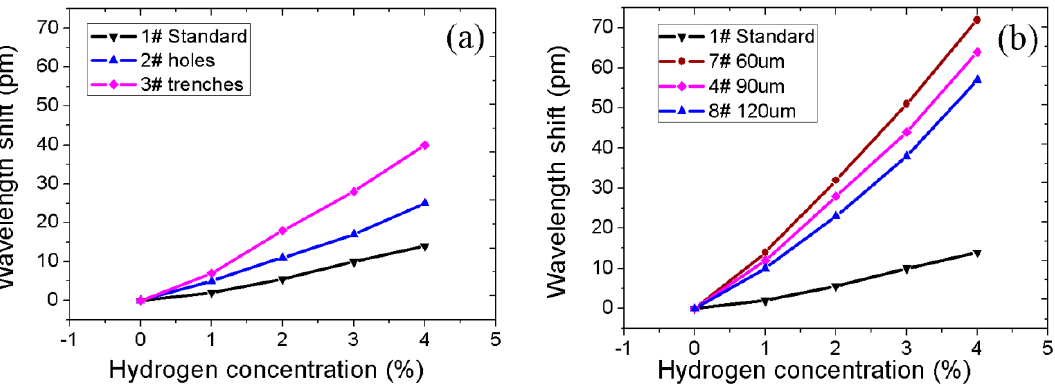
Figure 8. ( a ) Wavelength shift of sensors with single-structure; ( b ) Wavelength shift of sensors with different pitches.